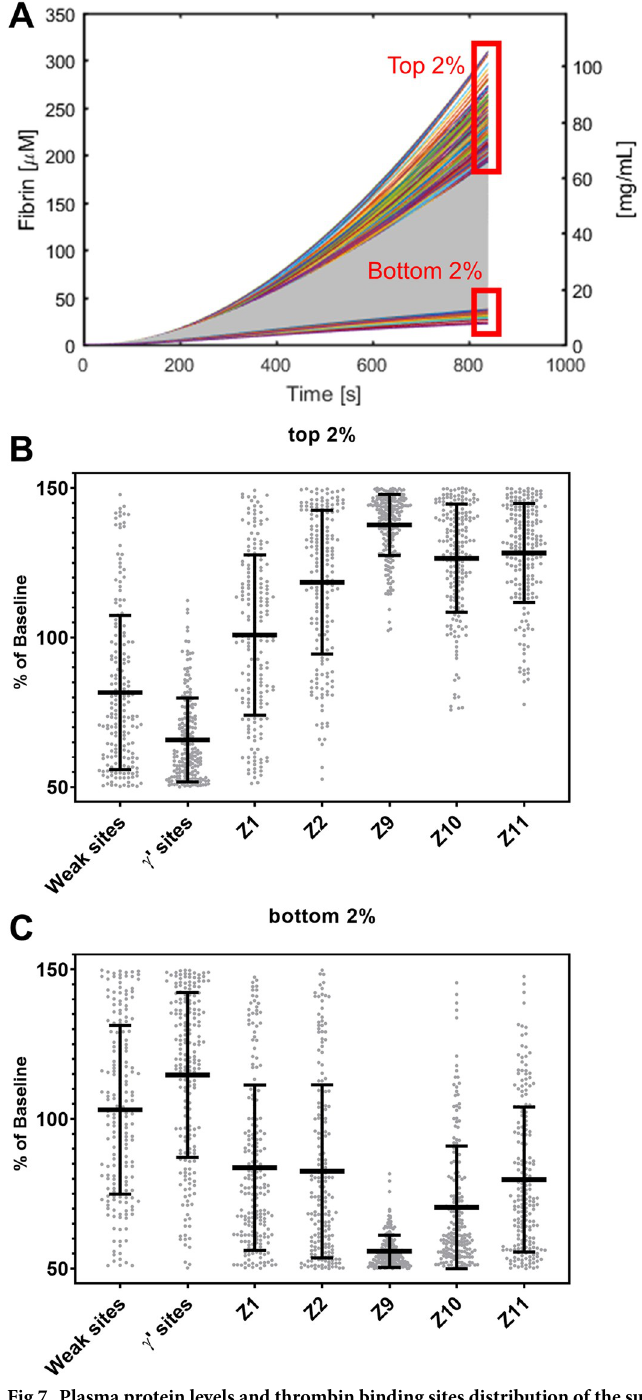
Fig 7. Plasma protein levels and thrombin binding sites distribution of the subsets of top and bottom 2% of fibrin concentration of 10,000 simulations. Fibrin concentration of 10,000 Monte Carlo simulations of 7 variables varying uniformly and independently. Top 2% and bottom 2% are labeled (A). Plasma protein levels and thrombin binding sites distribution of top 2% (B) and bottom 2% of the simulations (C).